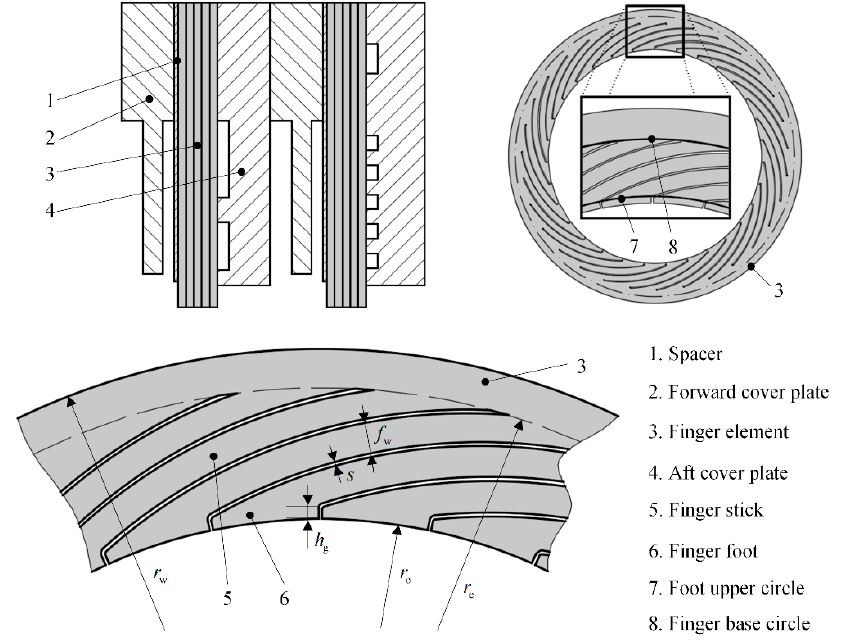
Figure 1. 2SFS design. Figure 1. 2SFS Table 1. Structural parameters of 2SFS.